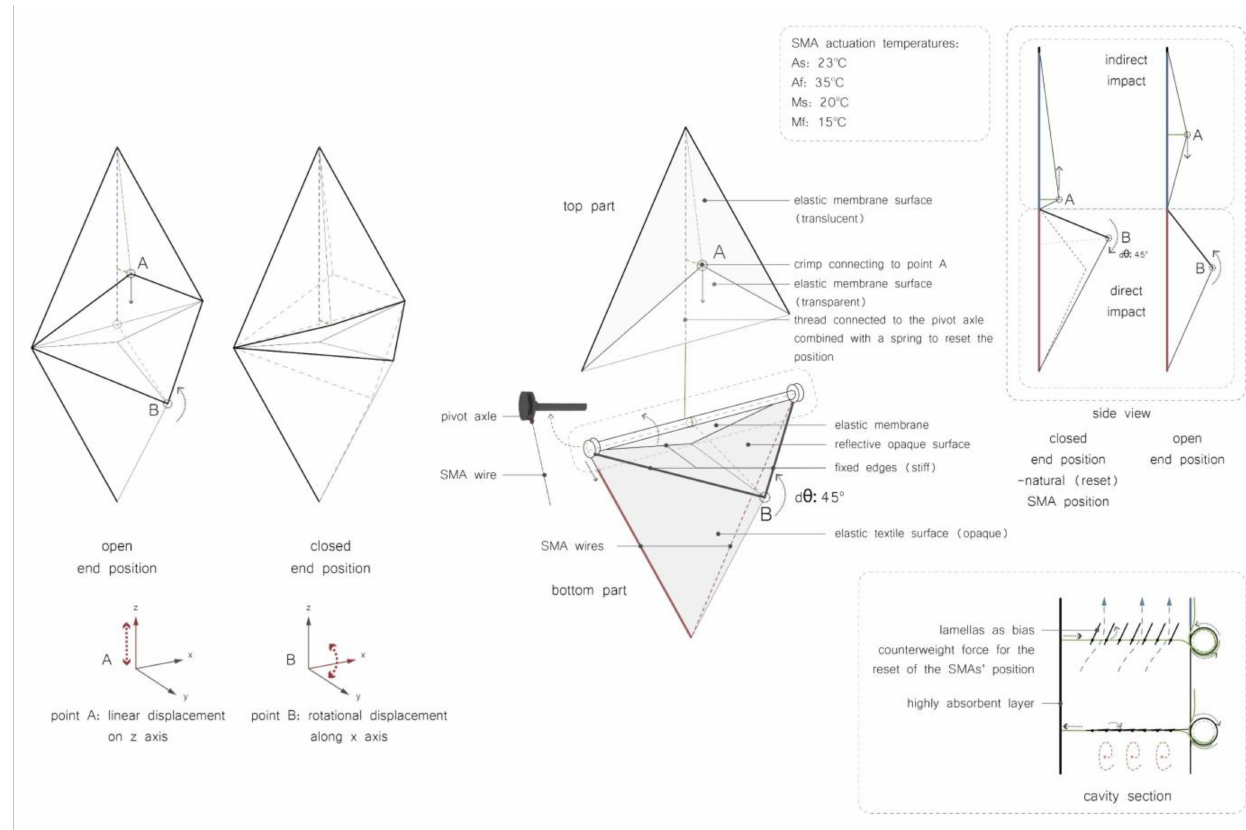
Figure 4. Conceptual sketches illustrating the SMA operating mechanism and